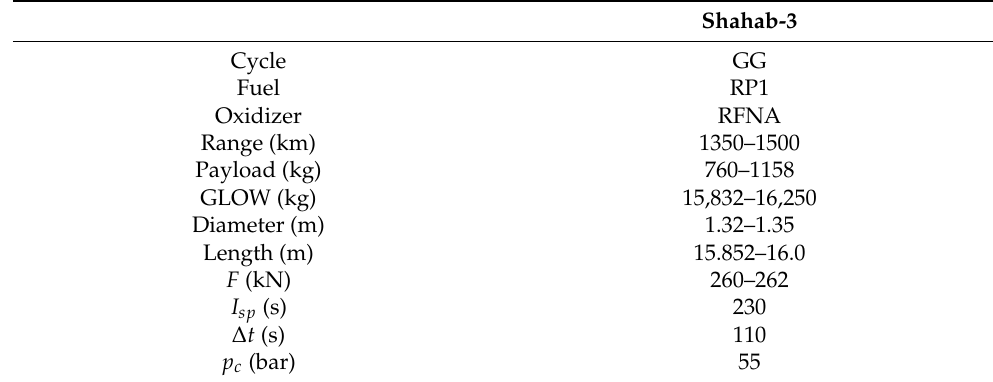
Table 4. Shahab-3 performance parameters and